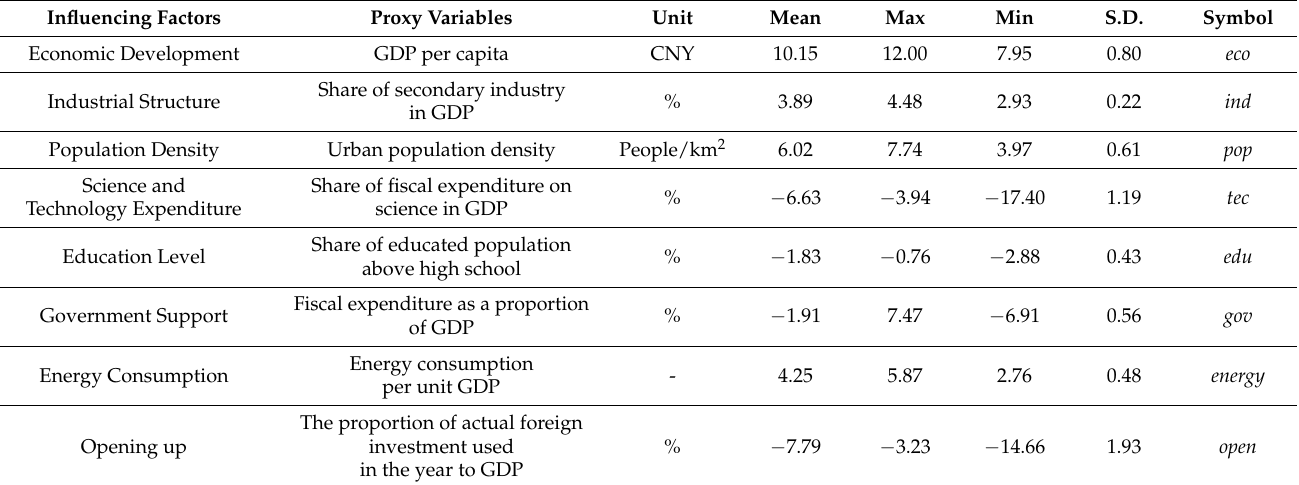
Table 4. Summary of Variable Information and Descriptive